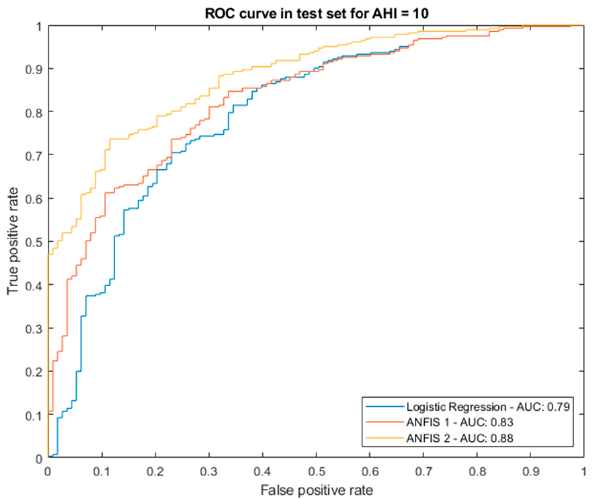
Figure 5. Comparison of areas under the curve for AHI = 10 after applying the correcting ap- proach.